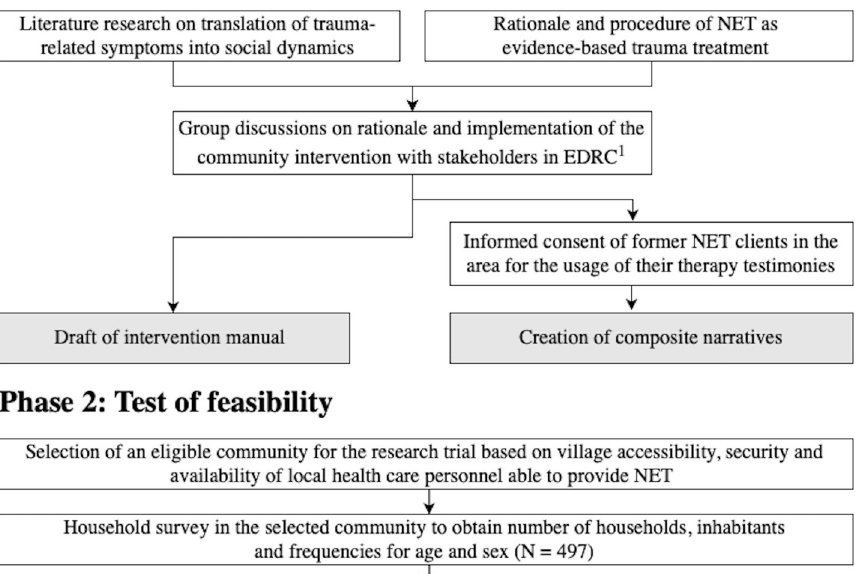
Fig 2. Flow of development and feasibility of NETfacts. Note. 1 for more information see S1 Table, 2 direct involvement is defined as either commencing NET, singular exposure session, or participation in at least one community meeting including composite narratives, whereas no direct involvement means individuals who were not directly involved but lived in the same community (and so may have encountered spill-over effects).